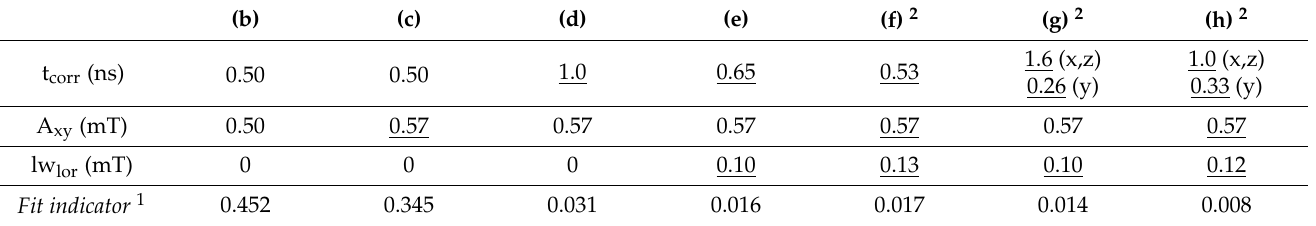
Table 1. Variable parameters used to obtain the simulations shown in magenta Figure 5b–h for sample 1. The underlined values indicate the modified parameters from the previous simulation. The other fixed parameters are: A z = 3.64 mT, g x = f(A z ) = 2.0084, g y = 2.0061 and g z = 2.0022 at 9.45